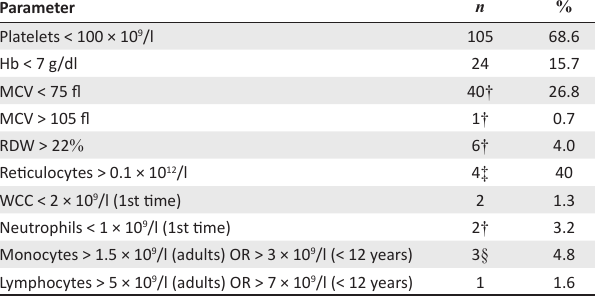
TABLE 3: Parameter rules triggered among patients with malaria. Parameter n